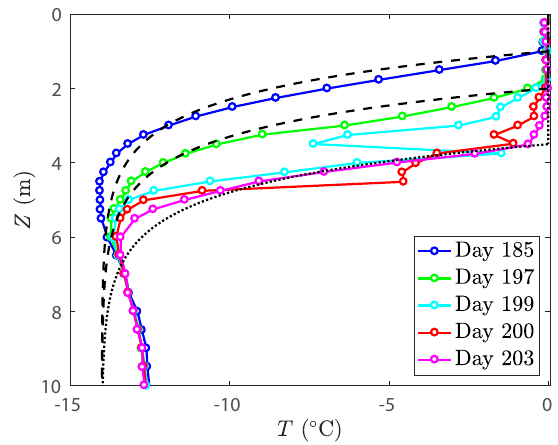
Figure 4. Data from Humphrey et al. (2012) show the propagation of refreezing fronts in Greenland firn. We overlay the approximate temperature solution for the temperature ahead of a refreezing front (black lines, Eq. 39). The speed of the front varies over the 18-day record: dashed lines use the initial speed and the dotted line uses the final speed. The far-field temperature is assumed to be constant in the model whereas the data show a local minimum in temperature at around 5m, which could be due to prior freezing fronts or the seasonal